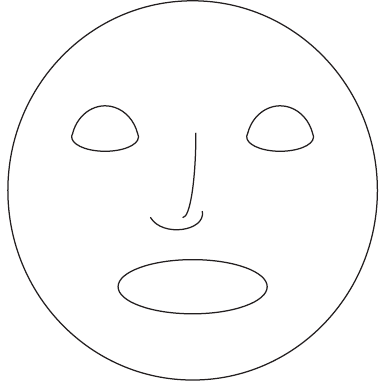
Figure 5: Location information of feature